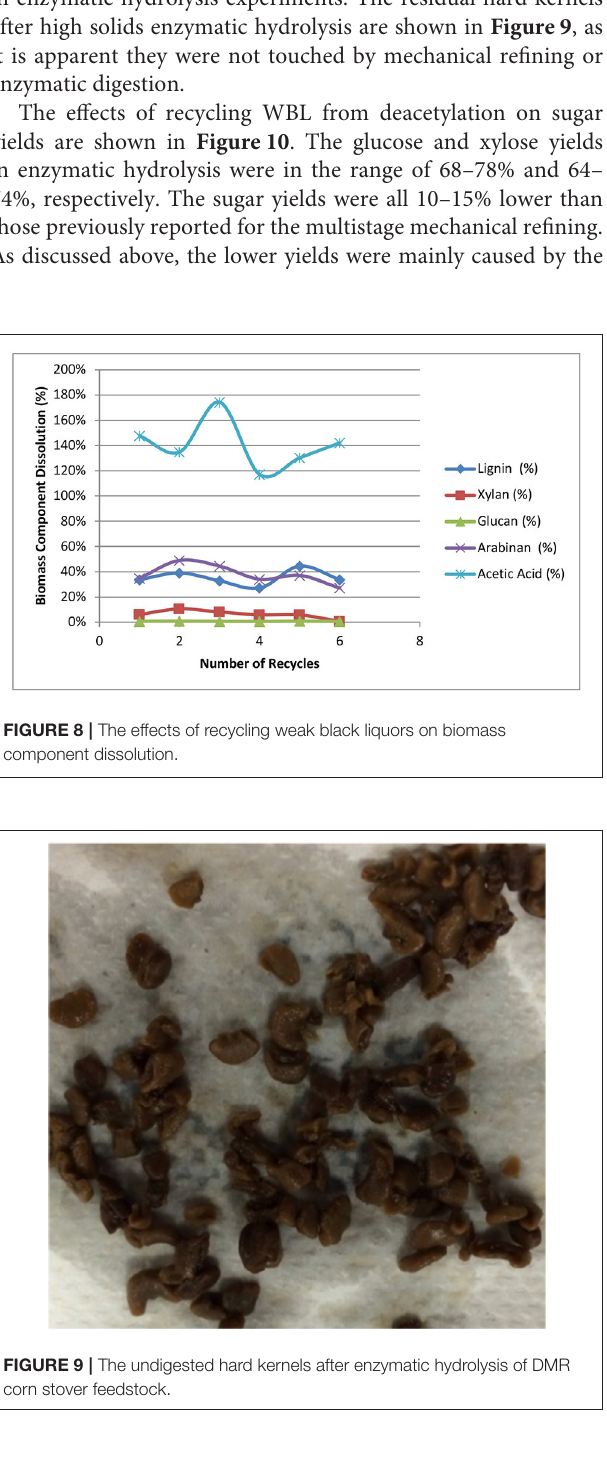
Frontiers in Energy Research |